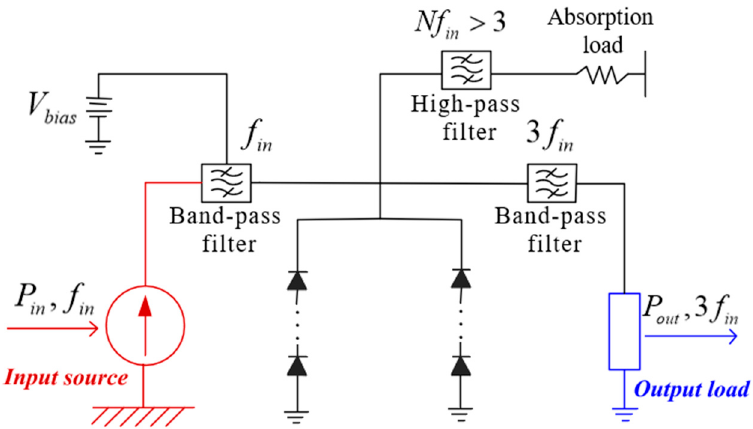
Figure 1. Frequency tripler circuit model.